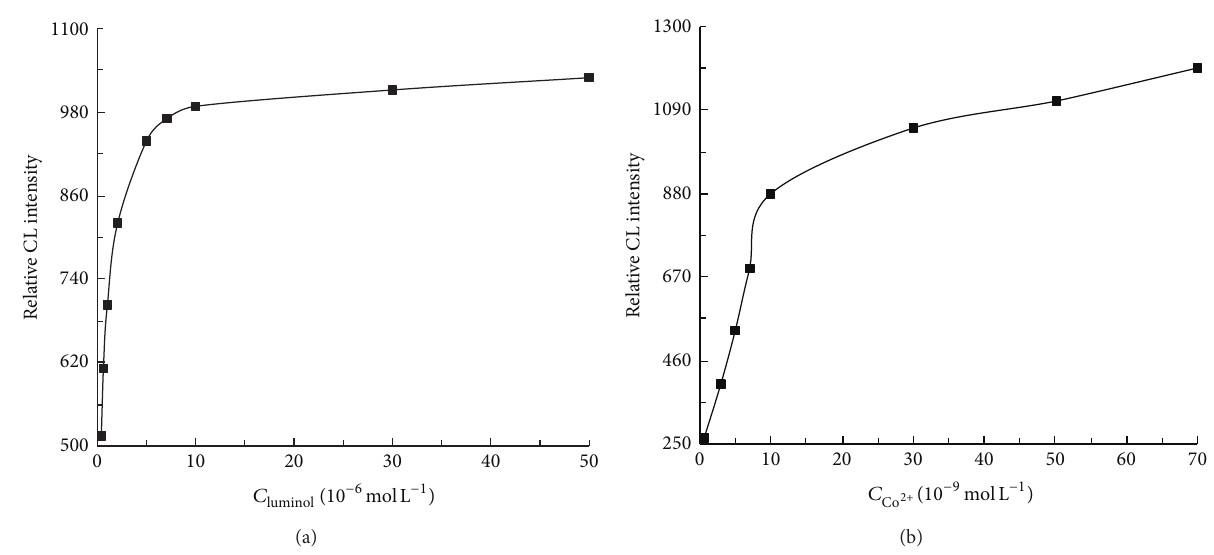
Figure 3: Effect of luminol (a) and Co 2+ (b) concentrations on the CL intensity. (a) The concentration of Co 2+ was 1.0 × 10 −8 molL −1 ; (b) the concentration of luminol was 5.0 × 10 −6 molL −1